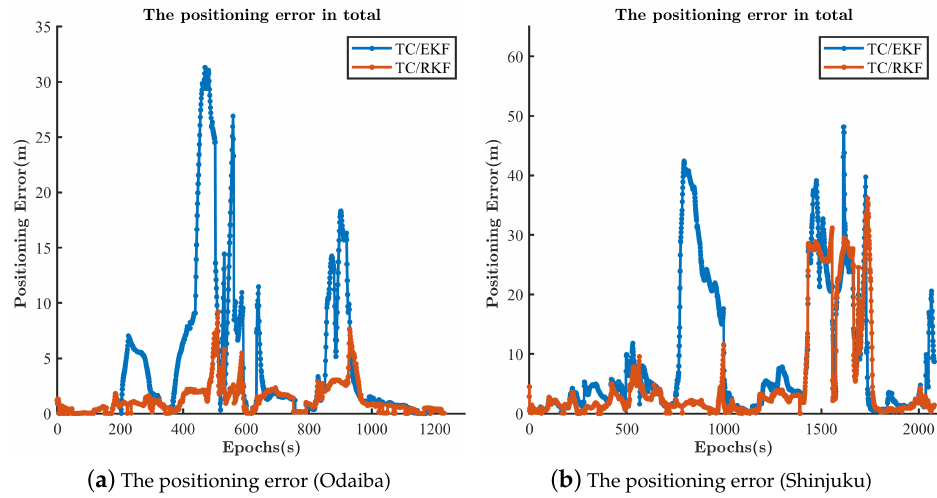
Figure 10. The positioning accuracy comparison between the integration with and without the outlier resistance.